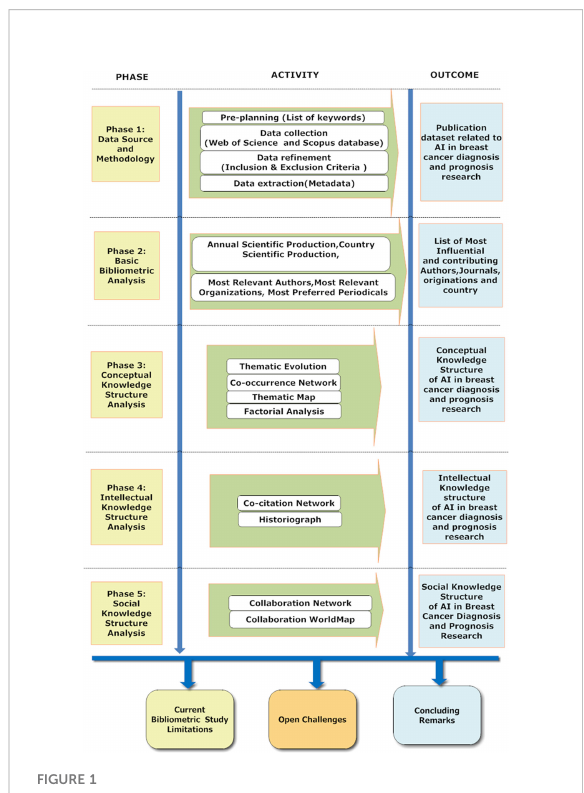
FIGURE 1 Bibliometric Process for Reviewing the AI publications in breast cancer diagnosis and prognosis research from 2000 to